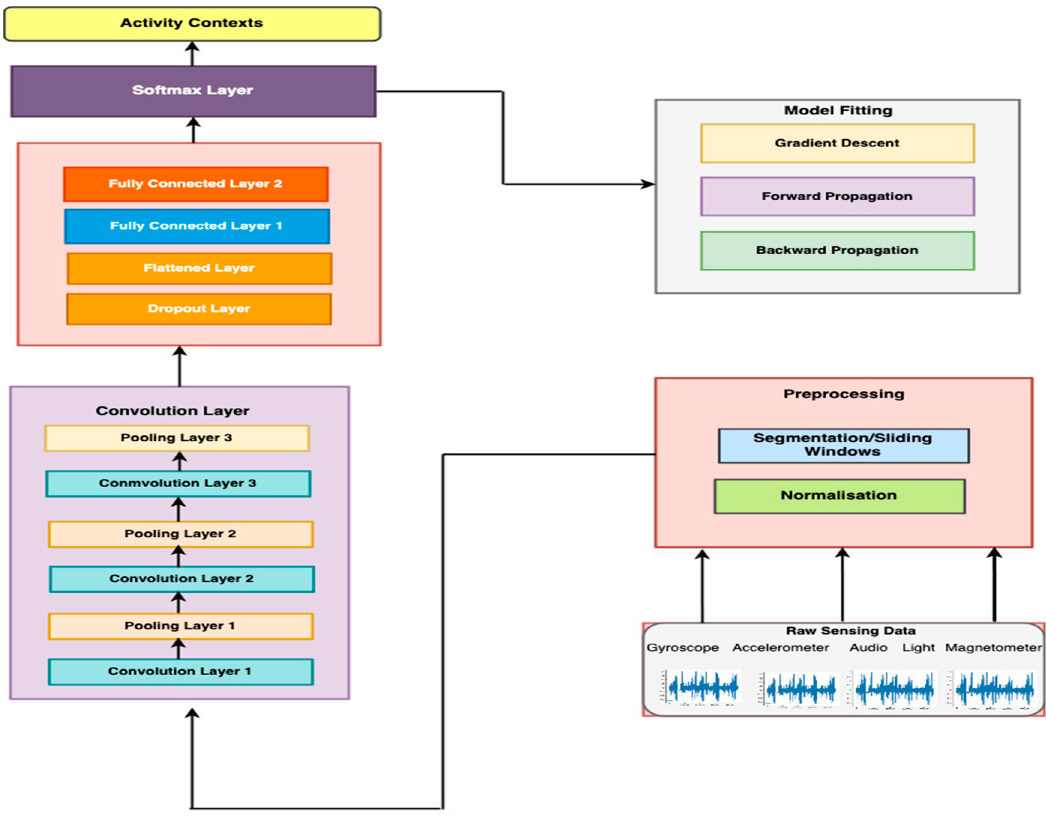
Figure 11. Deep convolutional neural network (DCNN) activity context recognition processes.